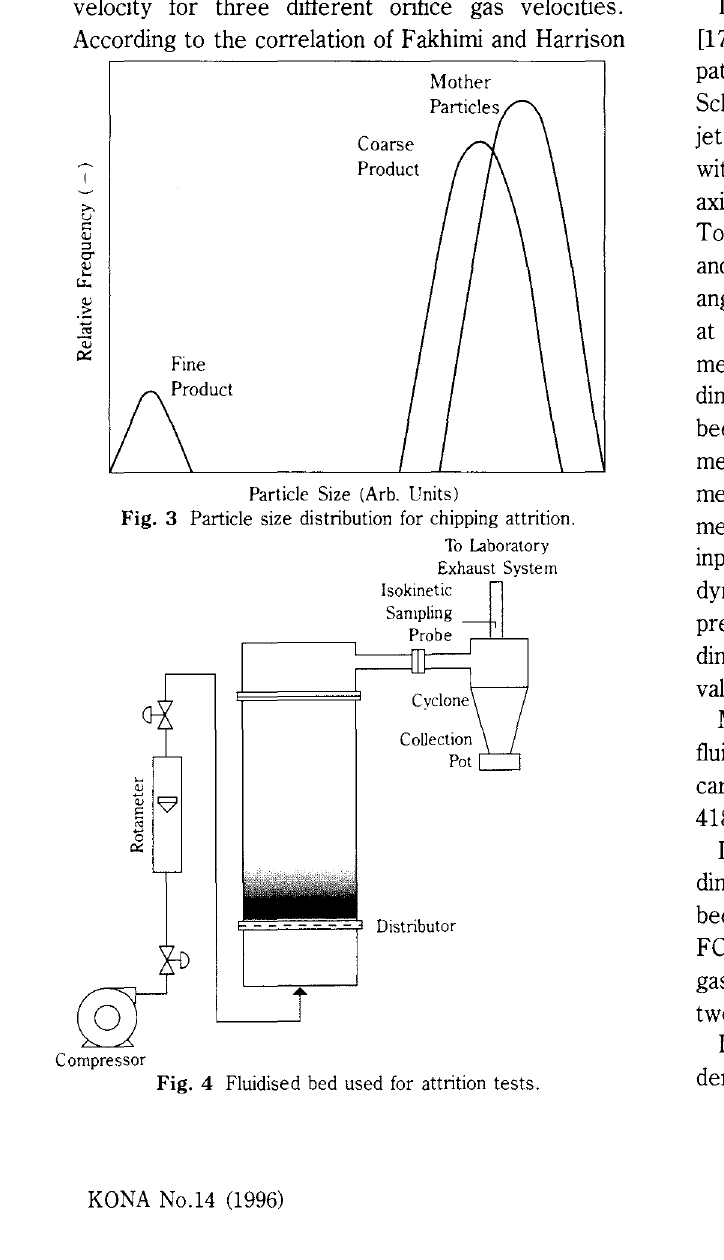
Fig. 4 Fluidised bed used for attrition